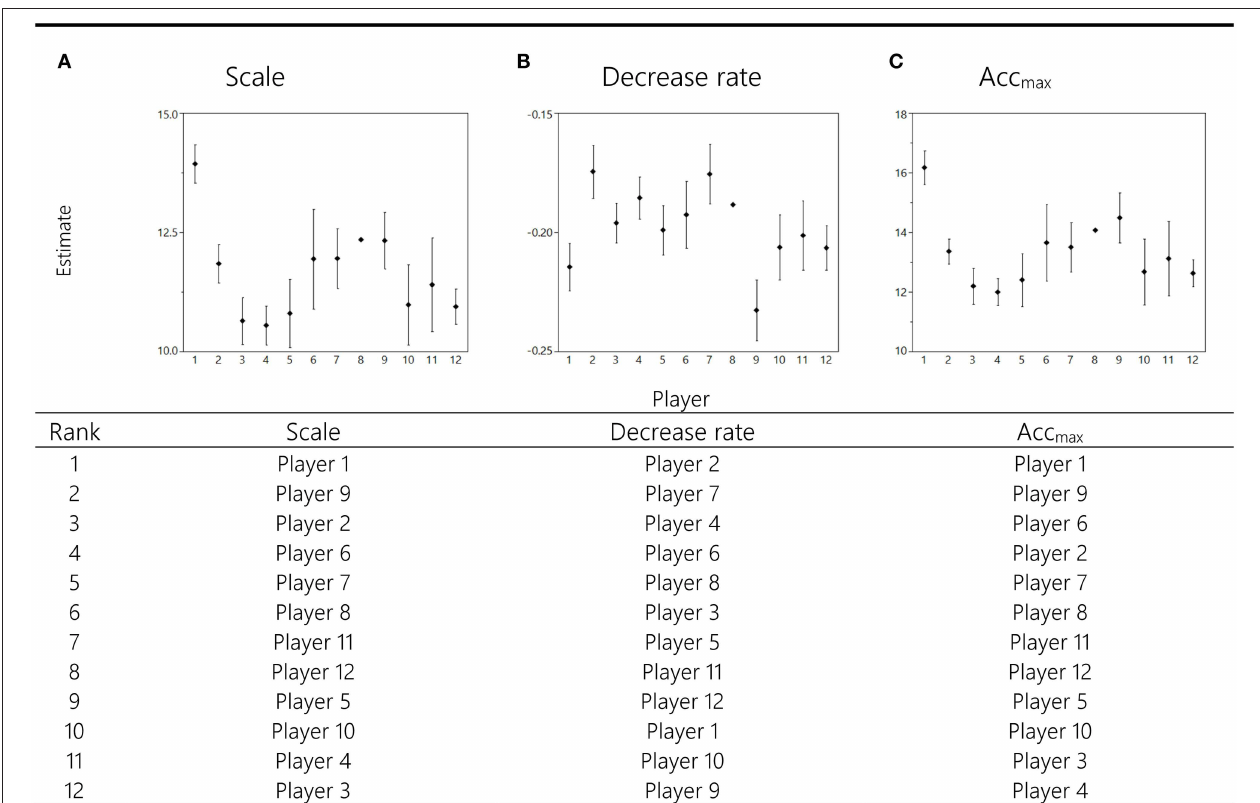
FIGURE 3 | Preliminary longitudinal results representing the |acc res | mean value SD for each function parameter across all matches for each player (x-axes). ± Estimated value for curve function parameters ( decrease rate , scale , and acc max ) are shown on the respective y-axes. The table below shows according results for longitudinal comparisons between players based on ranks. Lower rank numbers indicate better performances with respect to scale, decrease rate , and acc max .